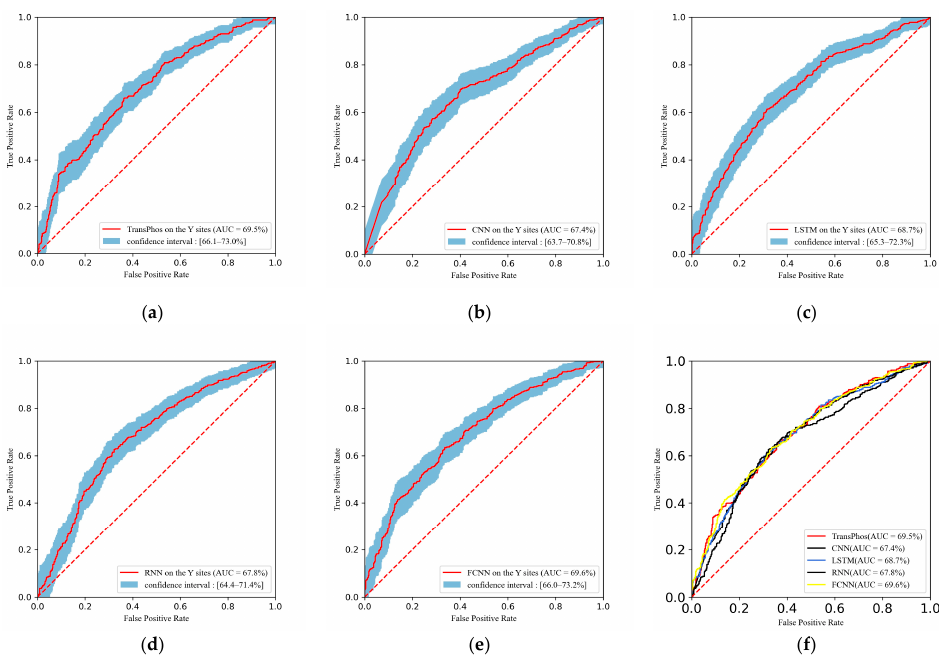
Figure A2. ROC curves containing 95% confidence intervals for different deep learning models on the Y sites of the training dataset P.ELM, 10-fold cross-validation was used. ( a ) ROC curve of the TransPhos model; ( b ) ROC curve of the CNN model. ( c ) ROC curve of the LSTM model. ( d ) ROC curve of the RNN model. ( e ) ROC curve of the FCNN model. ( f ) Performance comparison on the Y sites of the P.ELM dataset.